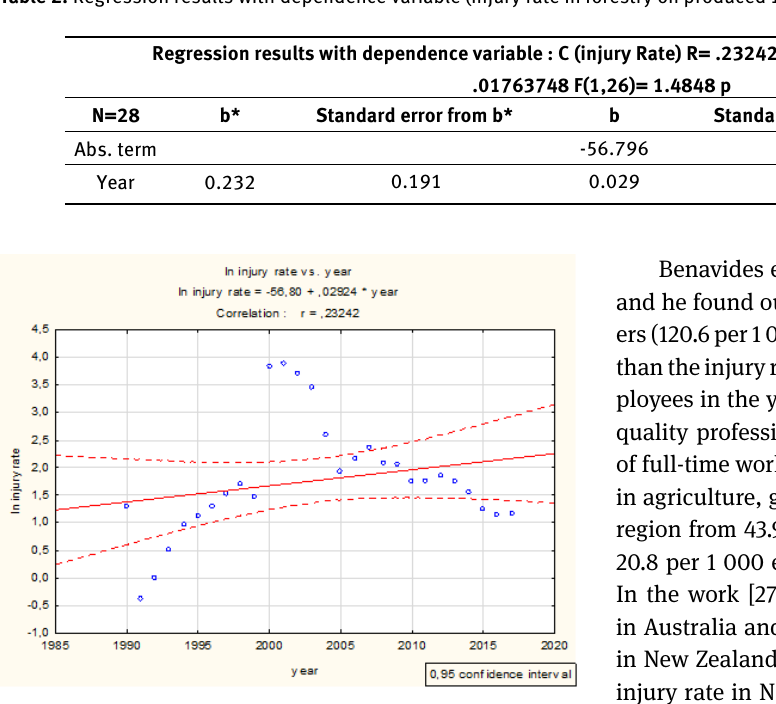
Table 2: Regression results with dependence variable (injury rate in forestry on produced 1000 m 3